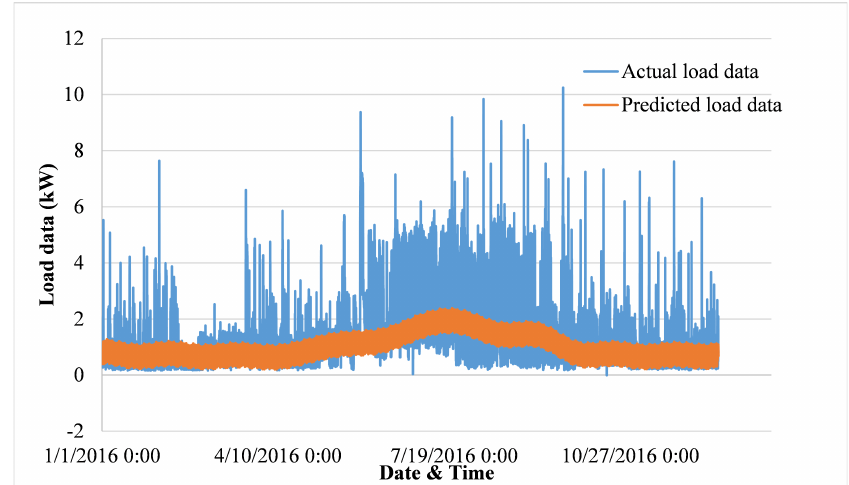
Figure 10. Comparison between real data and predicted data for the Facebook Prophet Model.